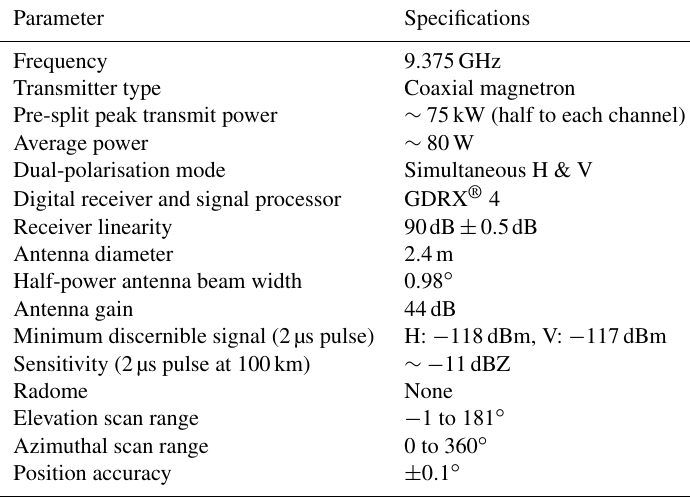
Table 1. Technical characteristics of the NXPol.